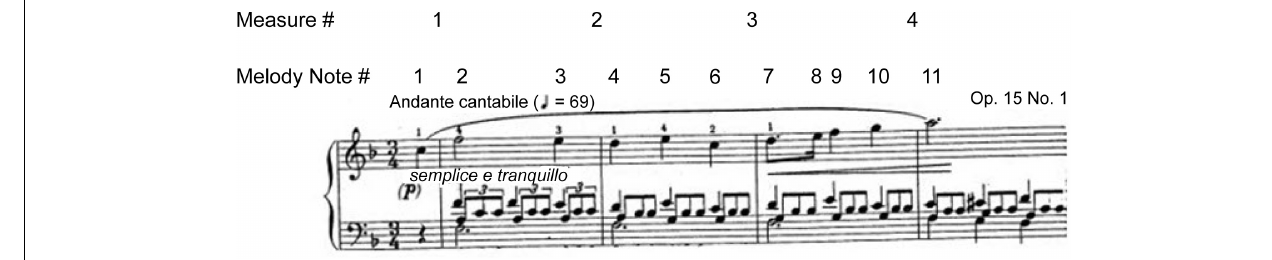
FIGURE 1 | Measures 1–4 from the piano score.